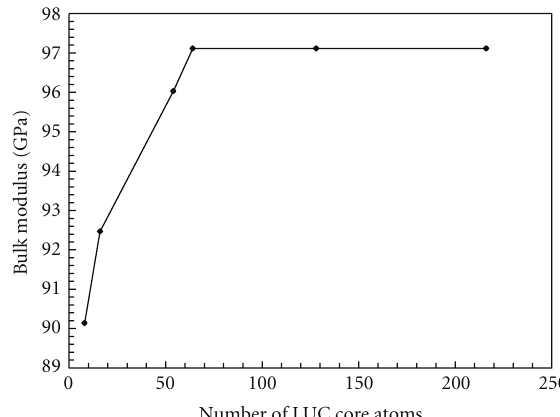
Figure 5: Cohesive energy of the core part of zb-AlP nanocrystals as a function of the number of core